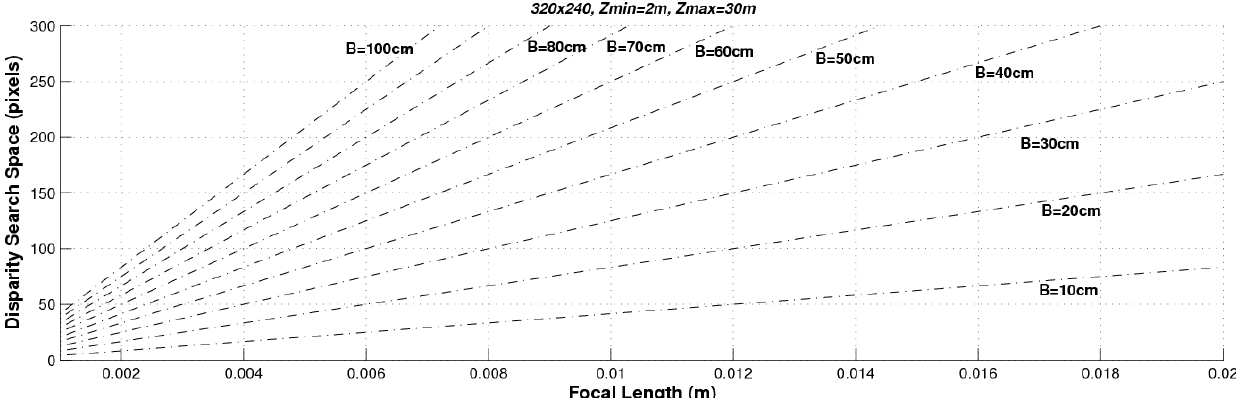
Figure 8. Size of the disparity search space as a function of the focal length, for different baselines with images of 320 × 240 px. The disparity search space is computed from 2 m to 30 m.